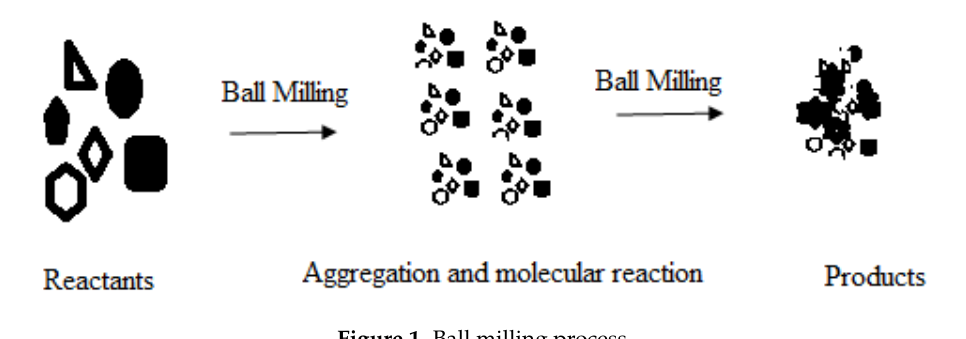
Figure 1. Ball milling process.